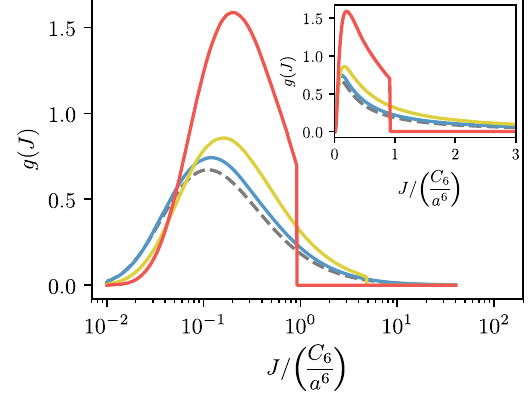
FIG. 7. Normalized probability distribution of nearest-neighbor interactions g ð J Þ for the densities given in Fig. 6 (blue line, ρ 1 . 25 × 10 8 cm − 3 ; yellow line, ρ 8 . 73 × 10 8 cm − 3 ; red S ¼ S ¼ 2 . 11 × 10 9 cm − 3 ). The dashed line depicts a distribu- line, ρ S ¼ tion corresponding to randomly placed spins. The blockade effect induces correlations in the system and hence the probability distribution at high densities becomes more peaked. This results in a decreased disorder compared to the completely random case. The inset shows the same data with linear axis to illustrate the narrowing of the distribution